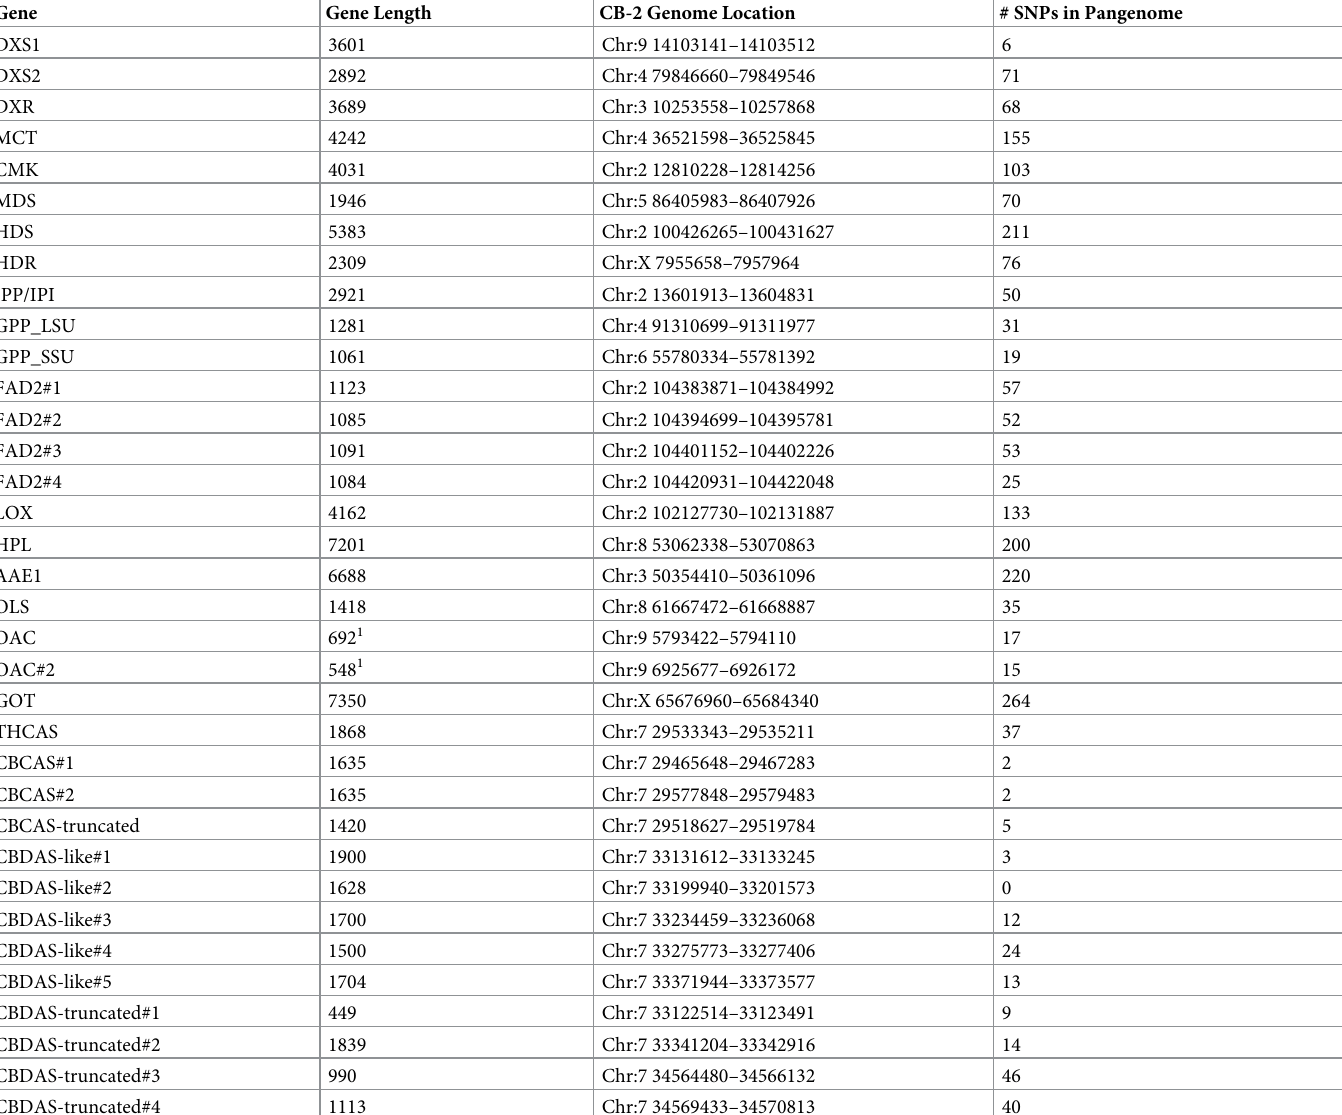
Table 2. Gene length defined as genome base-pair length including introns, and location within Cannbio-2 with accompanying consensus SNP data from pangenome. Gene Gene